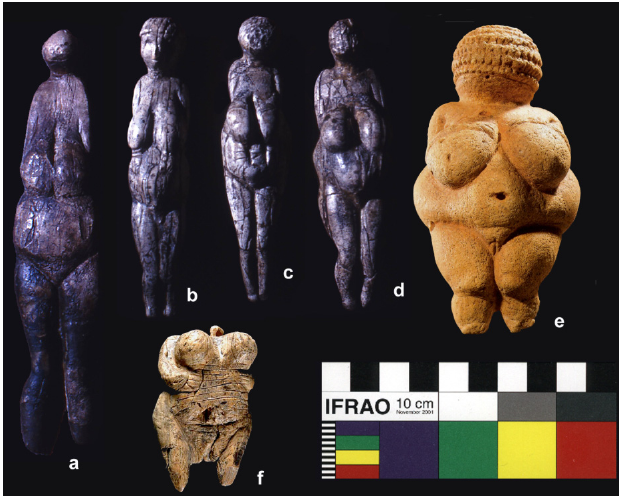
Figure 17. A few of the so-called “Venus” figurines: a–d = Avdeevo (Russia) No’s 1, 7, 8 and 6; e = Willendorf (Austria); f = Hohle Fels (Germany). All are between 25 ka and 35 ka